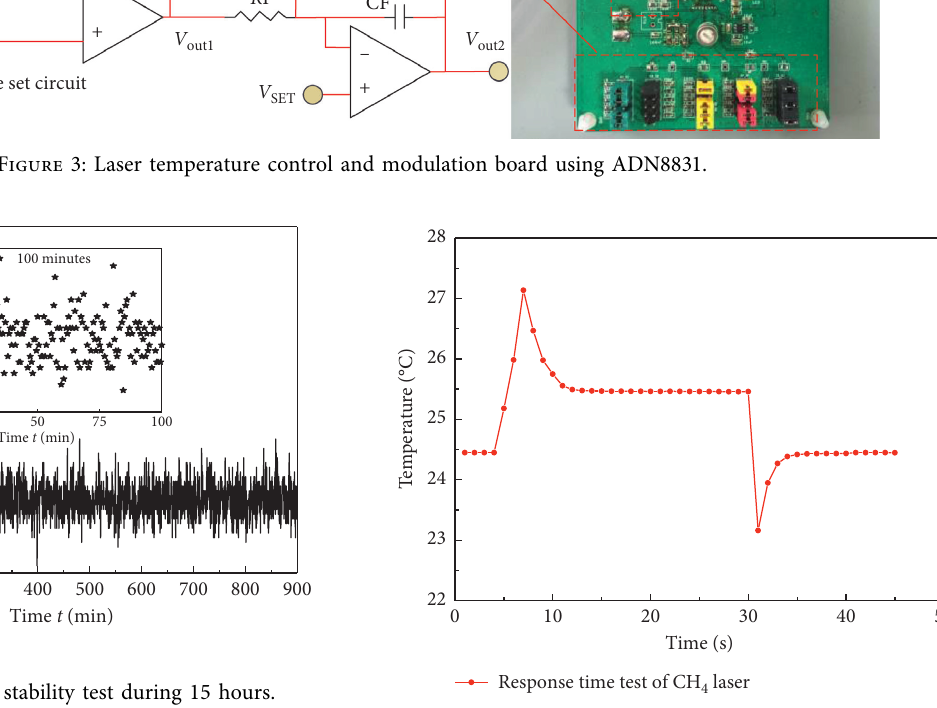
Figure 5: Response time test by using step as 1 ° C.